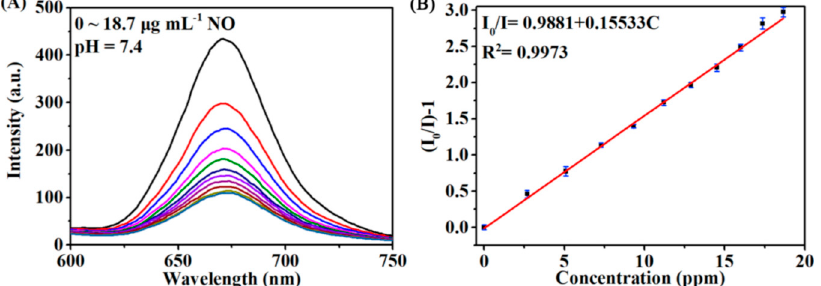
Figure 15. ( A ) Evolvement of the luminescence spectra of the Pt-TCPP/H4TCPE@UiO-66 NPs as a function of NO concentration from 0 to 18.7 μ g mL − 1 at pH = 7.4. ( B ) The corresponding Stern-Volmer plots of the quenching luminescence intensity as a function of NO concentration at pH = 7.4. Reprinted with permission from [79]. Copyright 2019 Elsevier.